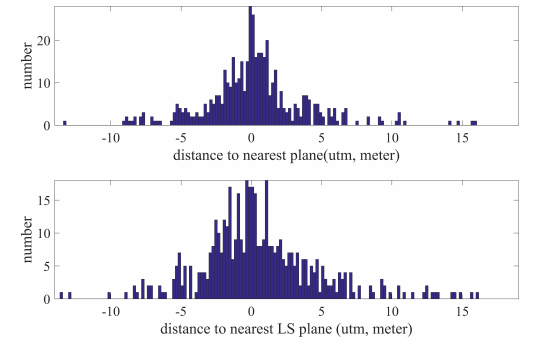
Figure 8. NCC-similarity values within the windows shown in Fig. 3. The red and blue ”+”-marks indicate the pixels corresponding to the maximum similarity within the classical rectangular window (blue) and the IMBLS window (red),